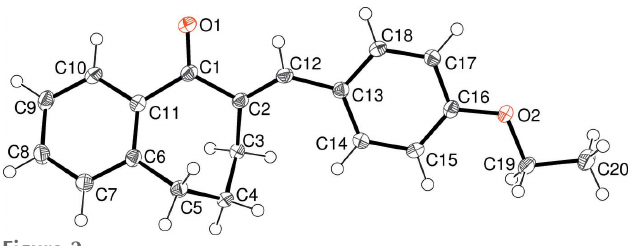
Figure 6 Overlay plot for (I)–(V), with (I) red, (II) blue, (III) orange, (IV) purple and (V)